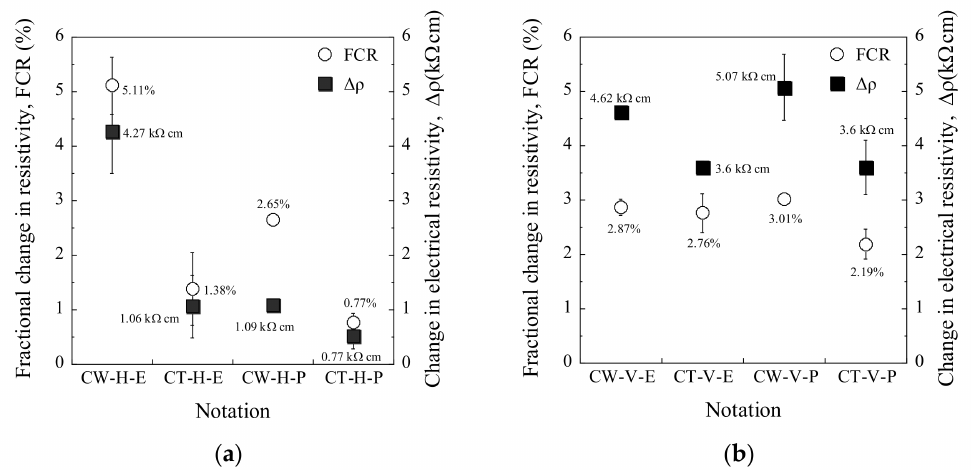
Figure 11. Effects of electrodes arrangement under compressive stress of 60 MPa: ( a ) H series; ( b ) V